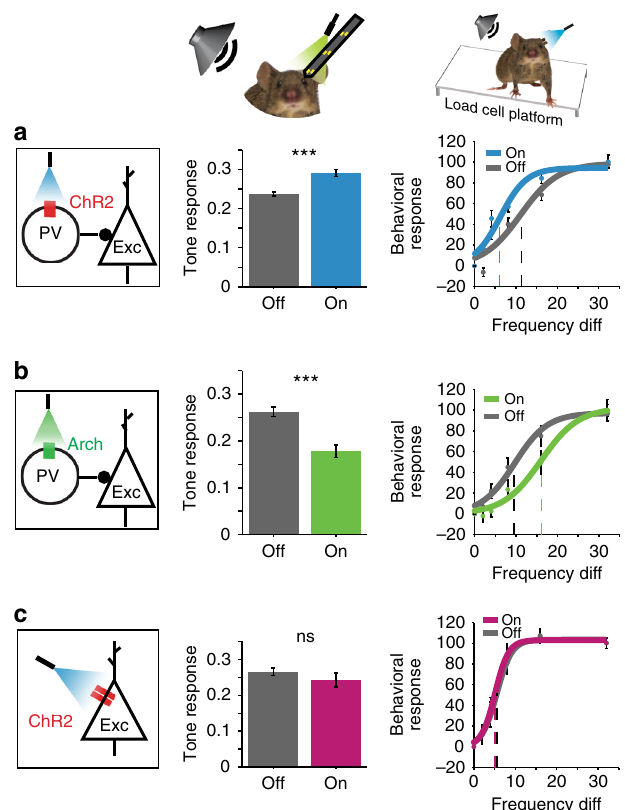
Fig. 2 Inhibitory interneurons affect auditory cortical responses and behavior. Activating PVs with ChR2 ( a ) increases tone-evoked responses and improves behavioral frequency discrimination acuity, whereas suppressing PVs using Arch has the opposite effect ( b ). ( c ) Direct activation of excitatory neurons with ChR2 does not change tone-evoked responses or behavioral frequency discrimination acuity on average. ( ce ) Left: diagram of optogenetic manipulation. Center: mean tone-evoked response magnitude under light-off and light-on conditions based on neuronal recordings. Right: Behavioral response to a shift in frequency under light-off and light-on conditions. Adapted from ref.